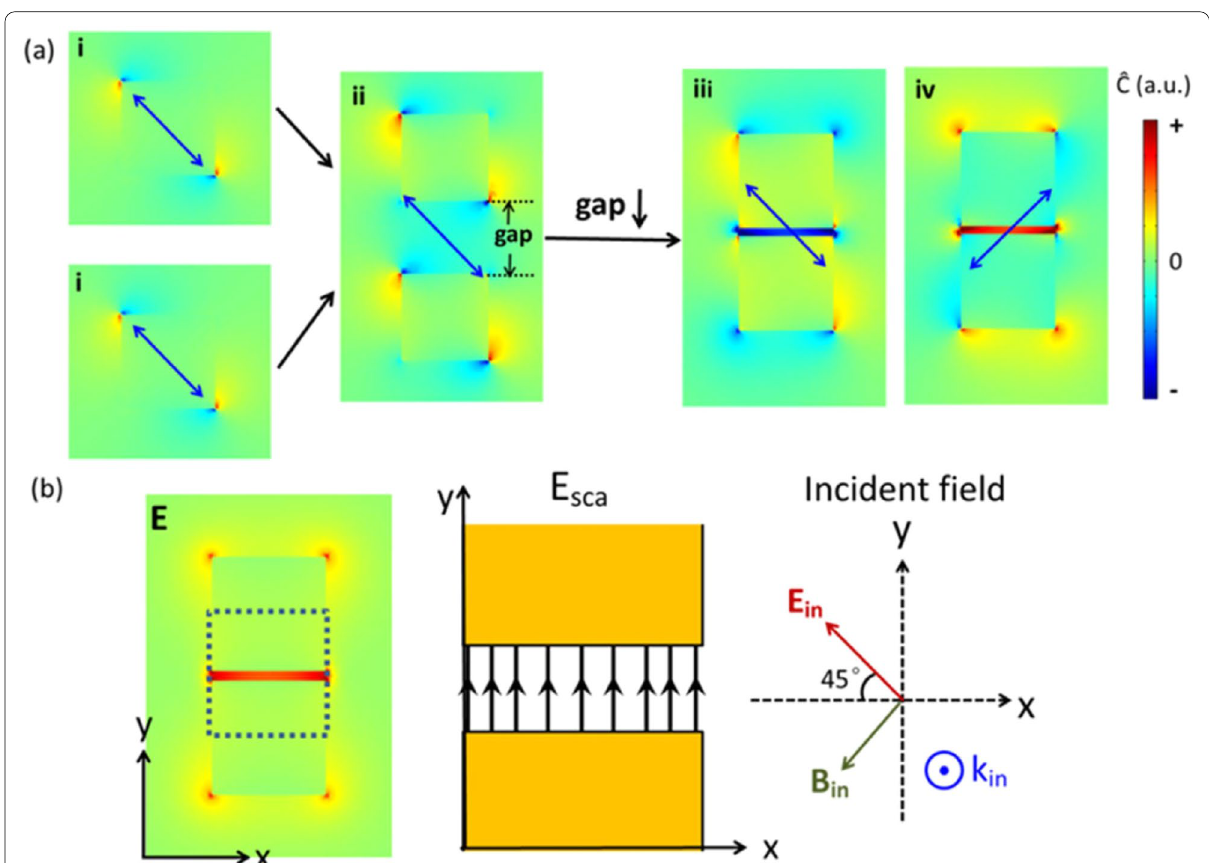
Fig. 18 Formation schematic of enhanced chiral near-fields with uniform optical chirality in the gap of a Au block (60 nm located on glass substrate in water surroundings, excited under polarizations indicated by blue arrows. a Chiral near-fields distributions of (i) one Au block, (ii) two blocks with a large gap d of 50 nm, and (iii–iv) block dimers with a small gap d of 5 nm. b Corresponding electric fields distribution of the case (a)-iii (left image); the right schematics show directions of incident fields and scattered fields (only fields in the gap are concerned) by a block dimer. All slices are cut from middle positions of the height. (Reprinted with permission from Ref.